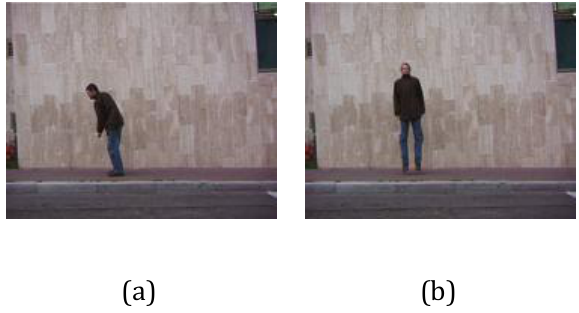
Figure 10. Abnormal “Standing” actions. ( a , b ) Misclassification